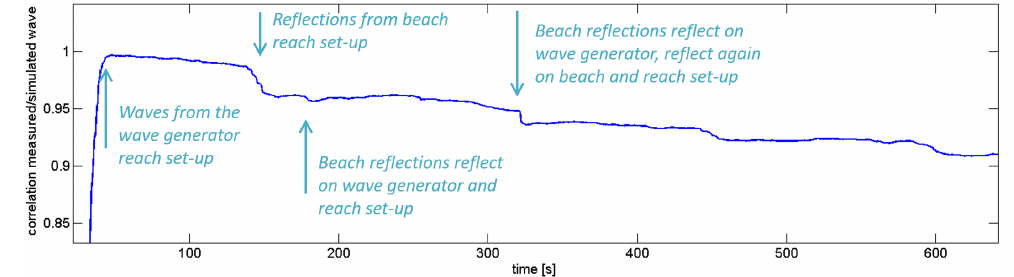
Figure 10. Deteriorating correlation between measured and simulated wave elevation at the location of the wind turbine linked against arrival of wave (reflections). Figure based on the same data as a figure in